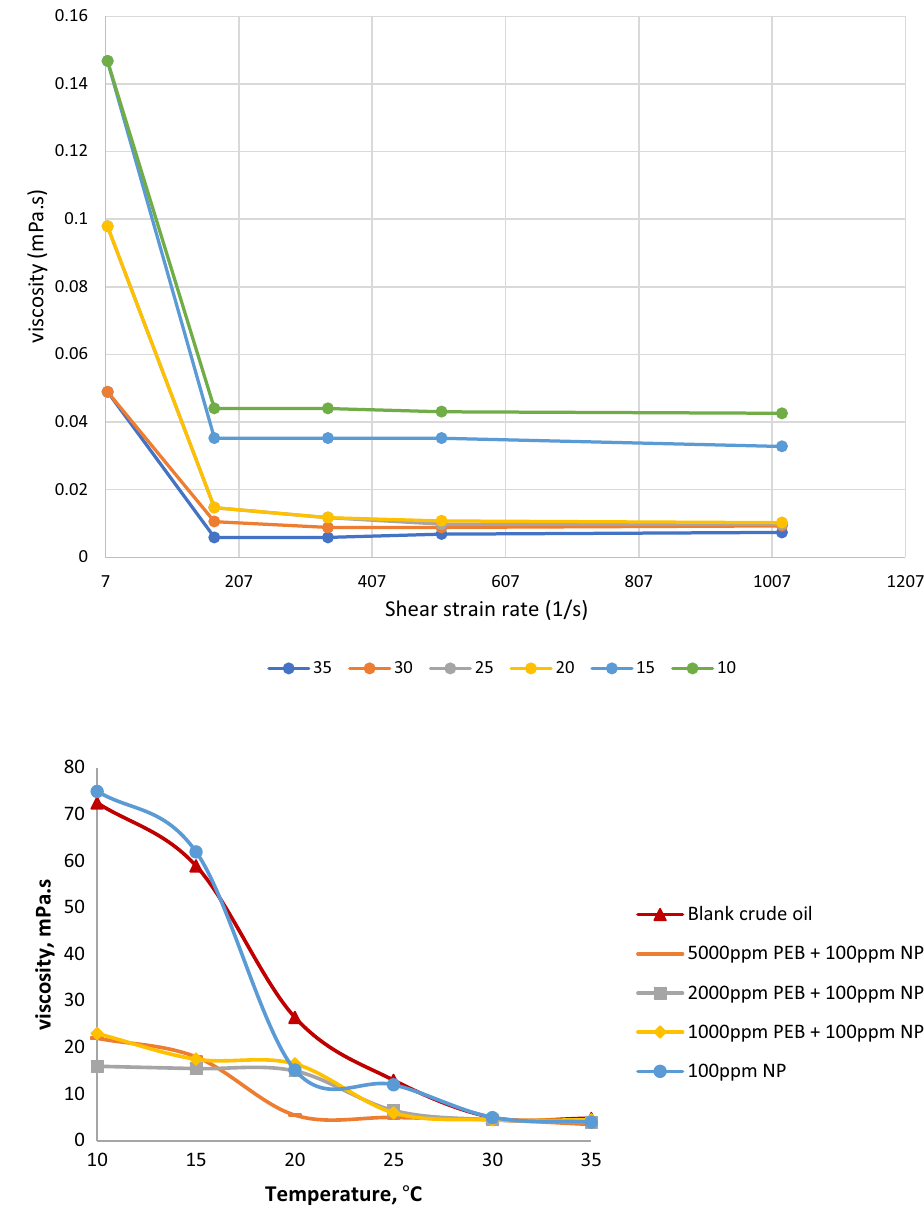
Fig. 7 Comparison of the vis- cosity of crude oil in the pres- ence of a different concentration of polymer and nanoparticle blend at varying